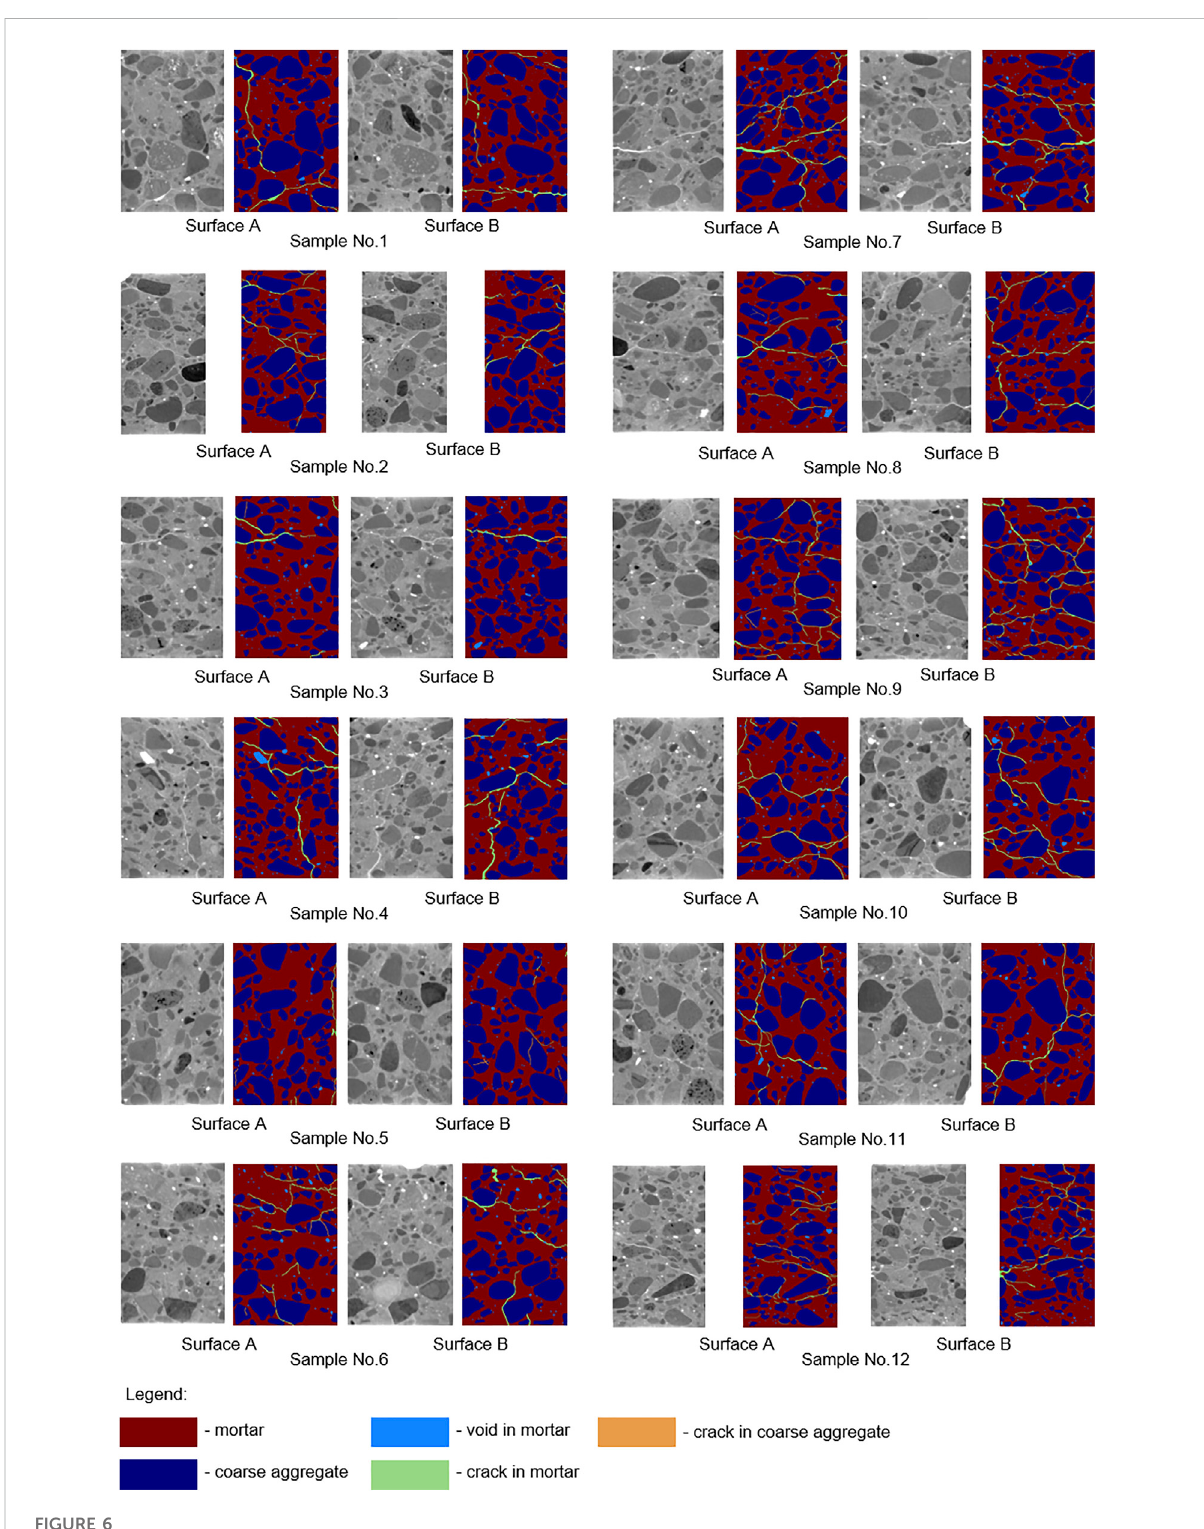
FIGURE 6 Schemes of concrete